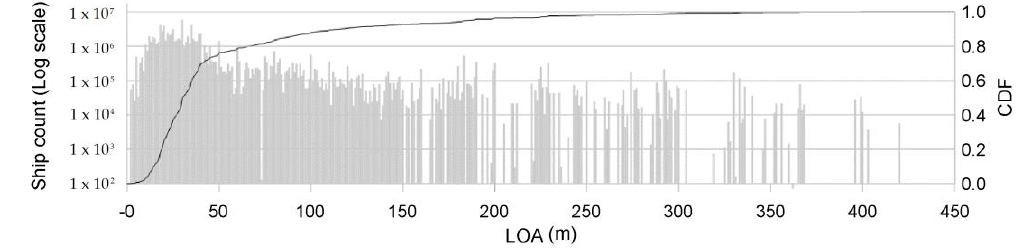
Figure 7. Distribution by LOA in Korean coastal waters. Table 5. LOA classification among the 10 groups. LOA (m)